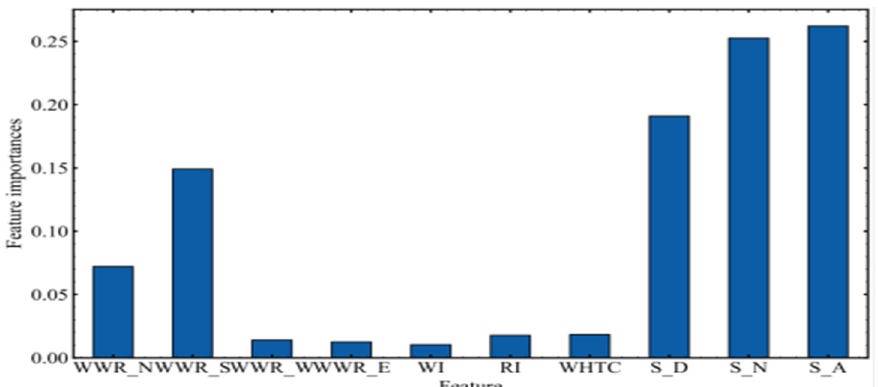
Figure 1. Analysis of the importance of shading components. Figure 1, Analysis of the importance of shading components. Figure 1, Analysis of the importance of shading components.